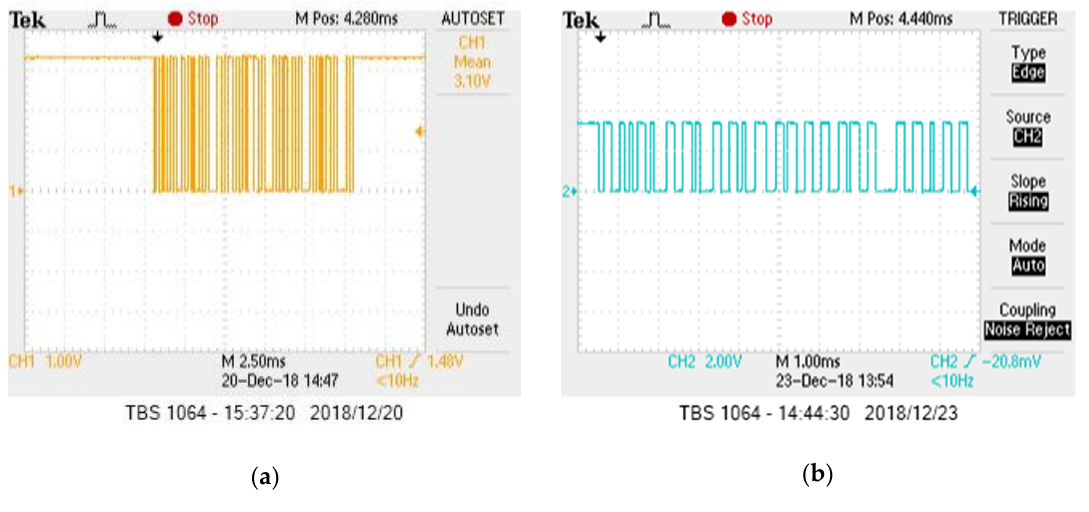
Figure 9. ZigBee data captured by Packet Sniffer.